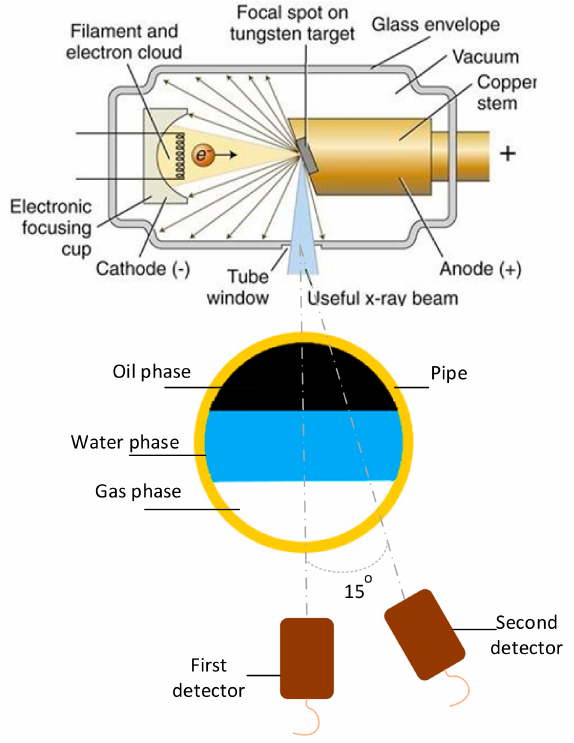
Figure 1. The structure of the simulated detection system using MCNPX.